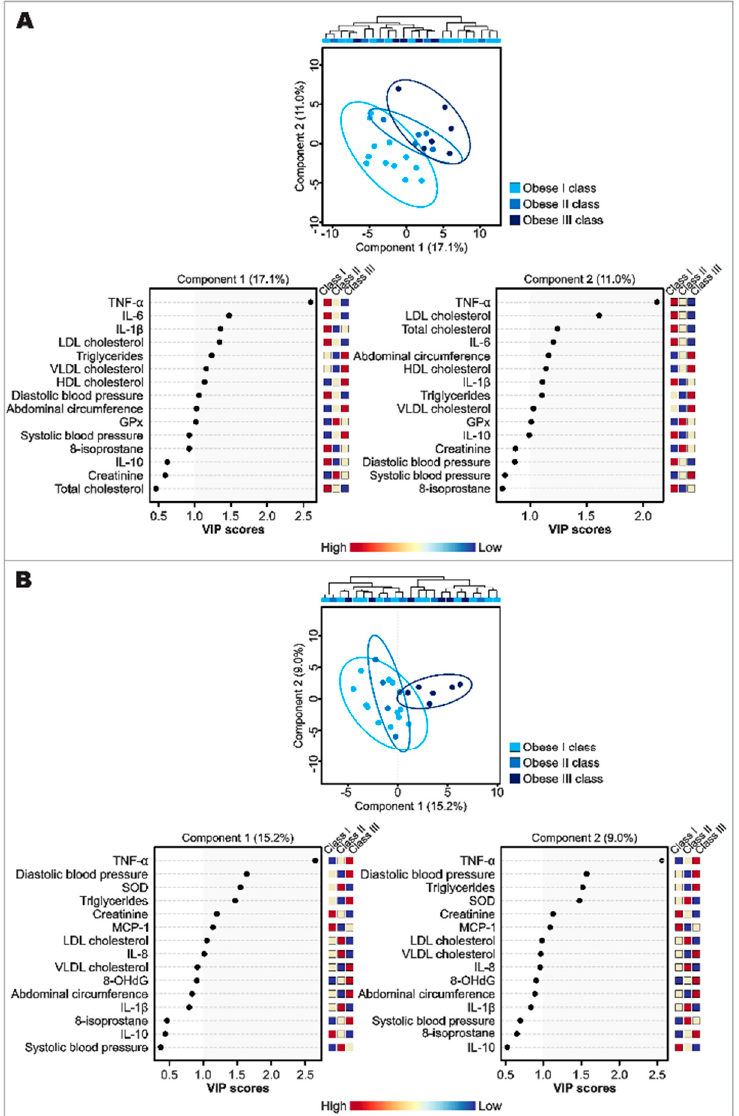
Figure 1. Discriminant analysis by partial least squares (PLS-DA) and VIP score plot (for the top 15 most important variables) of anthropometric and biochemical parameters, and inflammatory and oxidative stress biomarkers after the intake of Pera ( A ) and Moro ( B ) orange juices in patients with class I, II, or II of obesity (sample sizes in MOJ intervention: obesity class I, n = 12; obesity class II, n = 5; obesity class III, n = 6). 8-OHdG: 8-hydroxy-2'-deoxyguanosine; BMI: body mass index; GPx: glutathione peroxidase; HDL: high-density lipoprotein; IL: interleukin; LDL: low-density lipoprotein; MCP-1: monocyte chemoattractant protein-1; ORAC: oxygen radical absorbance capacity; SOD: superoxide dismutase; TNF- α : tumor necrosis factor alpha; VLDL: very-low-density lipoprotein.